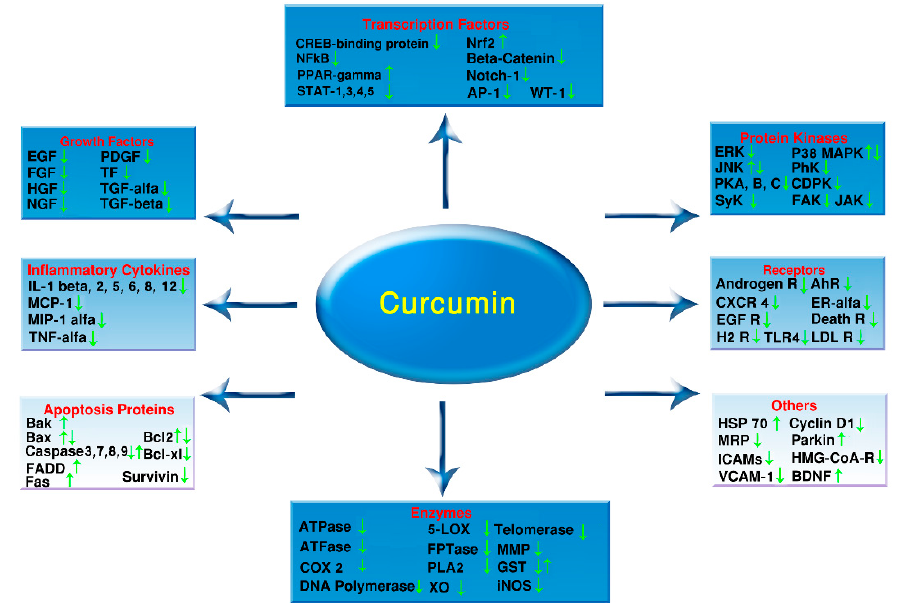
Figure 2. Cellular and molecular targets of curcumin. Curcumin directly or indirectly interacts with numerous molecular targets and modulates their activity and function. AH R: Aryl hydrocarbon receptor, AP-1: Activator protein 1, Bax: Bcl-2-associated X protein, BDNF: Brain-derived neurotrophic factor, CDPK: Calcium-dependent protein kinases CRDB: Curcumin Resource Database, CREB: cAMP response element-binding protein, COX-2: Cyclooxygenase-2, CXCR 4: C-X-C Motif Chemokine Receptor 4, EGF: Epidermal growth factor, ER-alfa: Estrogen receptor alfa, ERK: Extracellular signal-regulated kinases, FADD: Fas Associated via death domain, FAK: Focal adhesion kinase, FAS: Fas cell surface death receptor, FGF: Fibroblast growth factors, GST: Glutathione-S-transferase, HAT: Histone acetylase, H2 R: Histamine H2 receptor, HDAC: Histone deacetylase, HGF: Hepatocyte growth factor, HMG-CoA-R: 3-hydroxy-3-methyl-glutaryl-CoA reductase, HSP-70: Heat shock protein 70, IBD: Intestinal inflammatory diseases ICAMs: Intercellular cell adhesion molecules, IL: Interleukin, iNOS: Inducible nitric oxide synthase, JAK: Janus kinase, JNK: c-Jun N-terminal kinases, LDL R: Low-DensityLipoproteinReceptor, MCP-1: Monocytechemoattractantprotein-1, MIP-1 α : Macrophage inflammatory proteins, MMP: Matrix metallopeptidases, MRP: Multidrug resistance-associated protein, NF κ B: Nuclear Factor kappa-light-chain-enhancer of activated B cells, NGF: Nerve growth factor, Nrf2: Nuclear factor erythroid 2–related factor 2, P38-MAPK: P38 mitogen-activated protein kinases PDGF: Platelet-derived growth factor, PhK: Phosphorylase kinase, PKA: Protein kinase A, PLA2: Phospholipase A2, PPAR-gamma: Peroxisome proliferator-activated receptor gamma, ROS: Reactive oxygen species, RNS: Reactive nitrogen species, SLP: Solid lipid particle, STAT: Signal transducer and activator of transcription, SyK: Spleen tyrosine kinase, TF: Tissue factor, TGF- α : Transforming growth factor alpha, TGF- β : Transforming growth factor beta, TLR: Toll-like receptors, TNF- α : Tumor necrosis factor alpha, UGT: Uridine diphosphate-glucuronosyltransferase, VCAM: Vascular cell adhesion molecule, XO: Xanthine oxidase, 5-LOX: